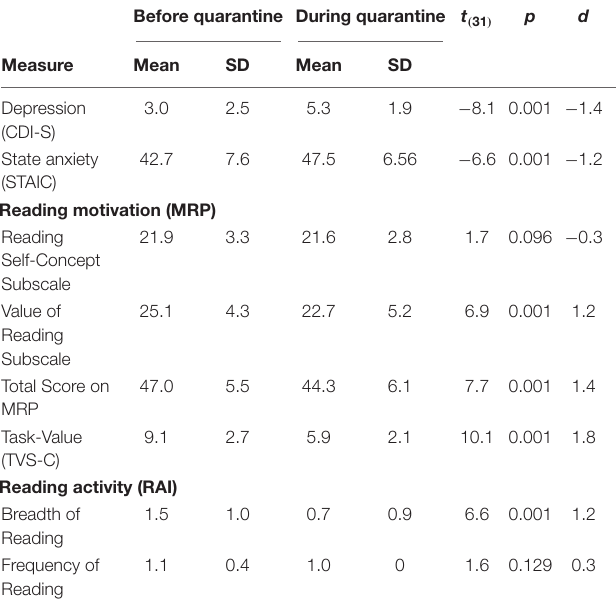
TABLE 3 | Psychological and motivational impact of Spain’s National Quarantine on children with dyslexia. Before quarantine During quarantine t ( 31